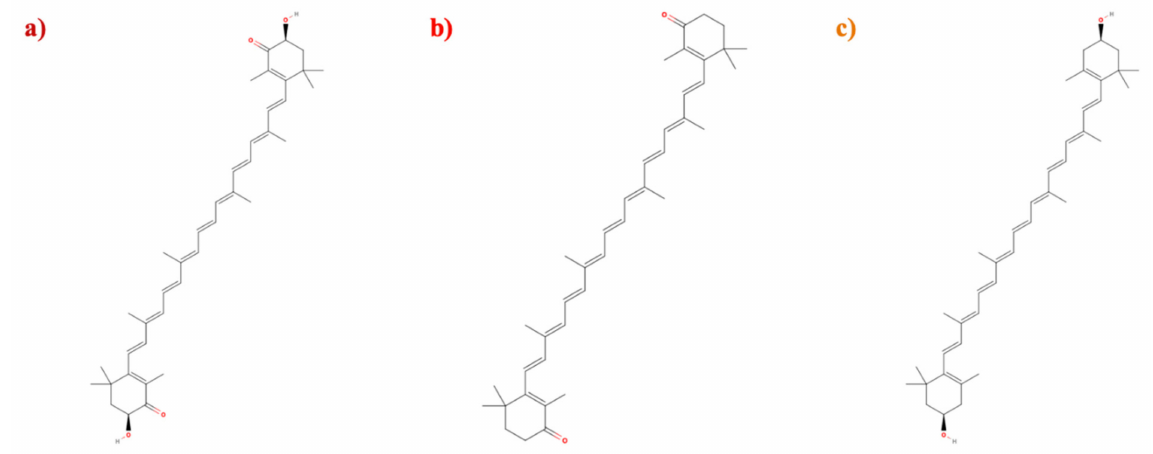
Figure 3. Molecular structures of the following bacterial pigments from the carotenoid family ( a ) Astaxanthin; ( b ) Canthax- anthin; ( c ) Zeaxanthin. (Structures made using MolView software)